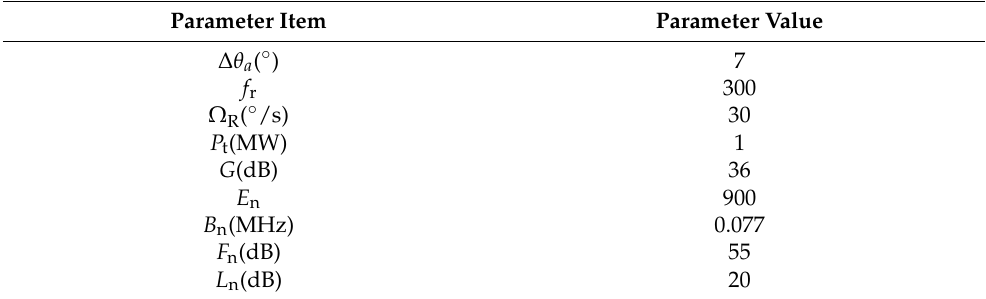
Table 4. Relevant data of a pulse Doppler